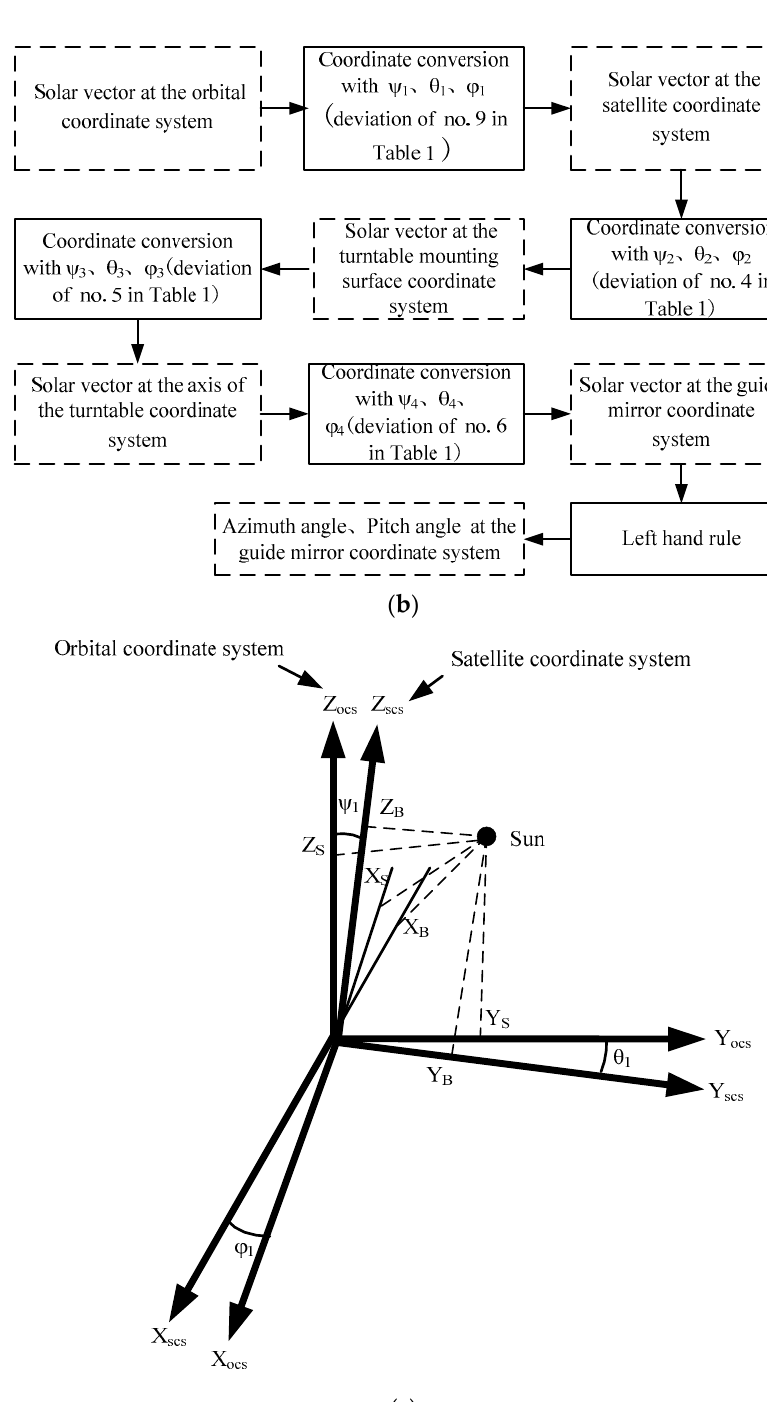
Figure 4. ( a ) Relationship between coordinate systems of the solar tracking system. ( b ) Coordinate transformation data flow diagram (see Table 1). ( c ) Diagram of the sun in the orbital coordinate system and the satellite coordinate system.